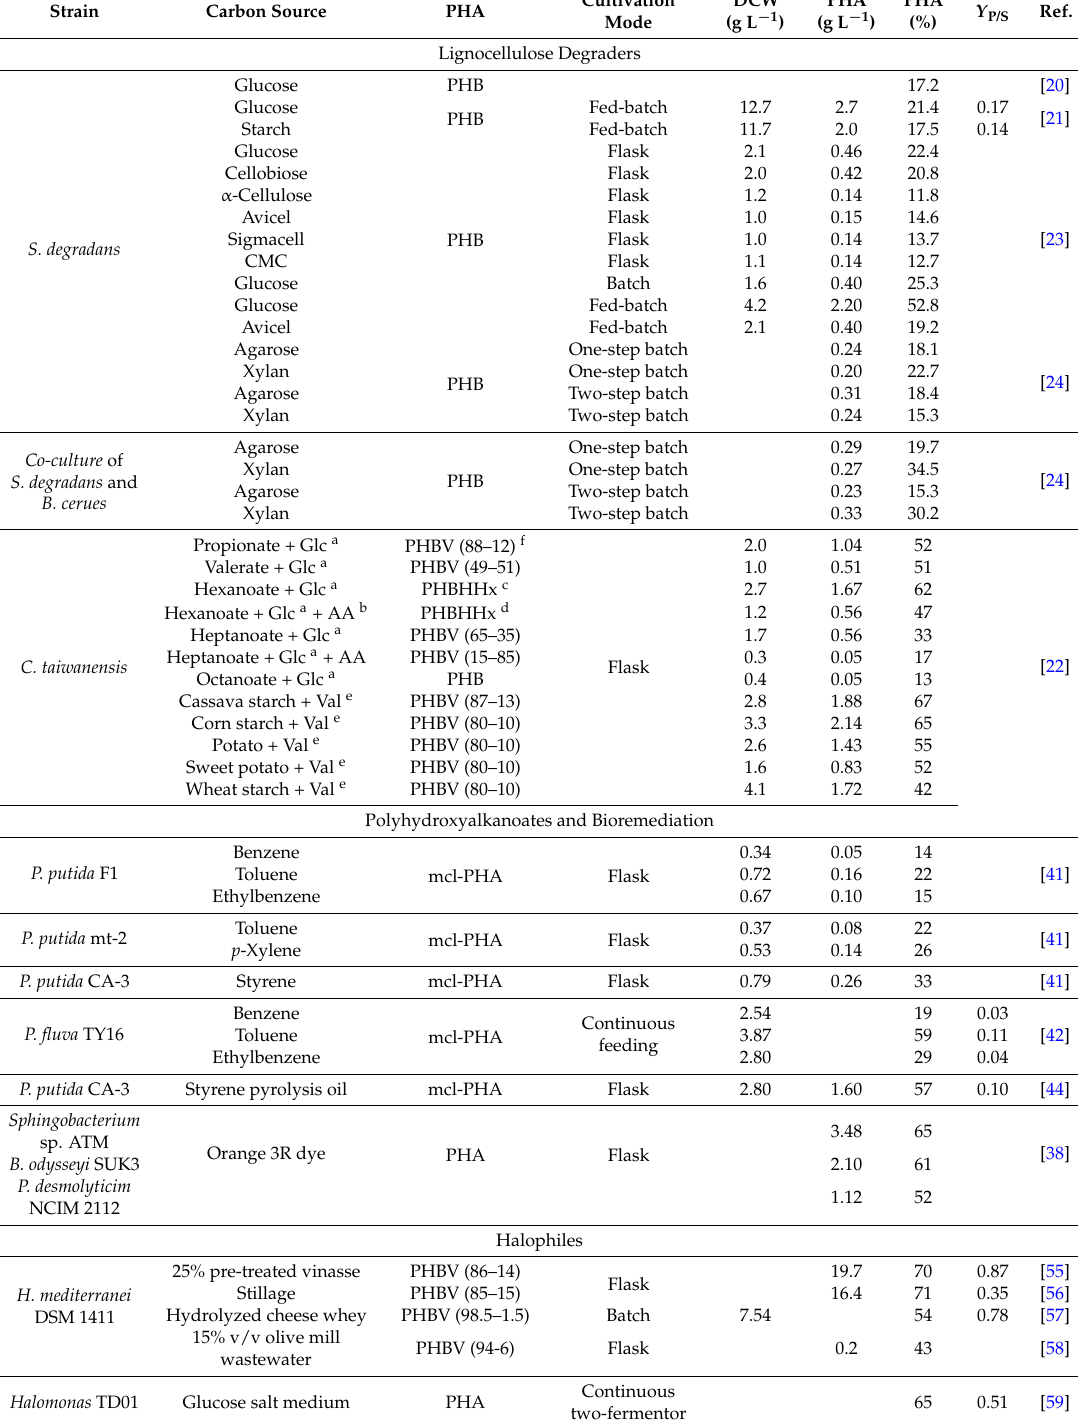
Table 2. Characteristic parameters describing PHA production from different types of bacteria.